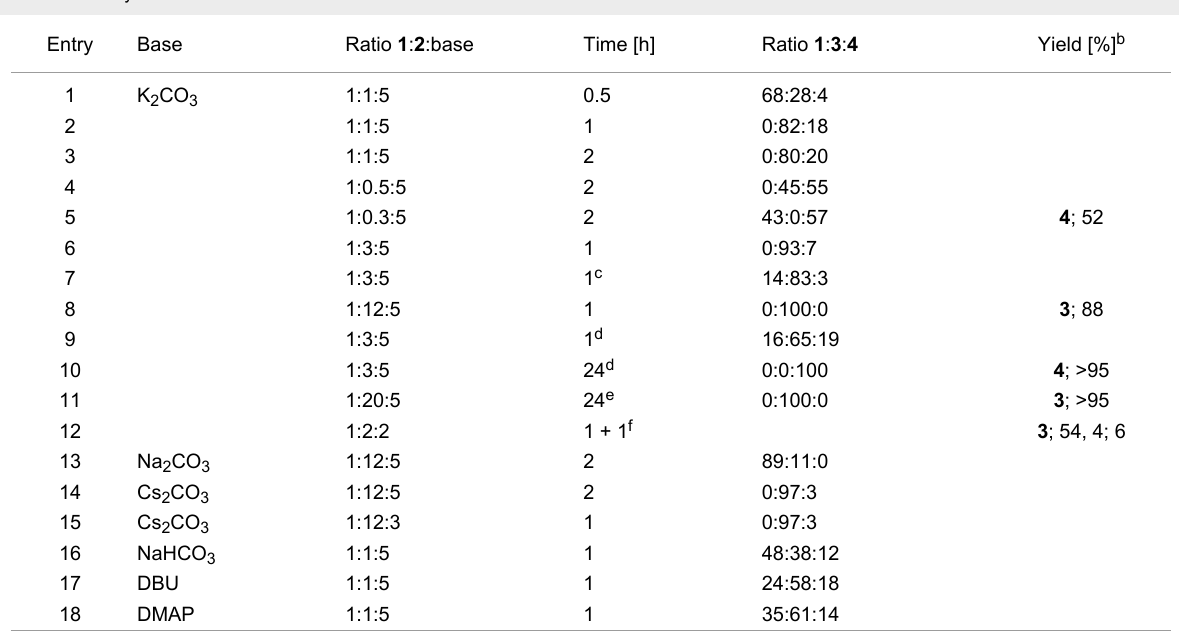
Table 1: N -Alkylation of imide 1 with 2. a